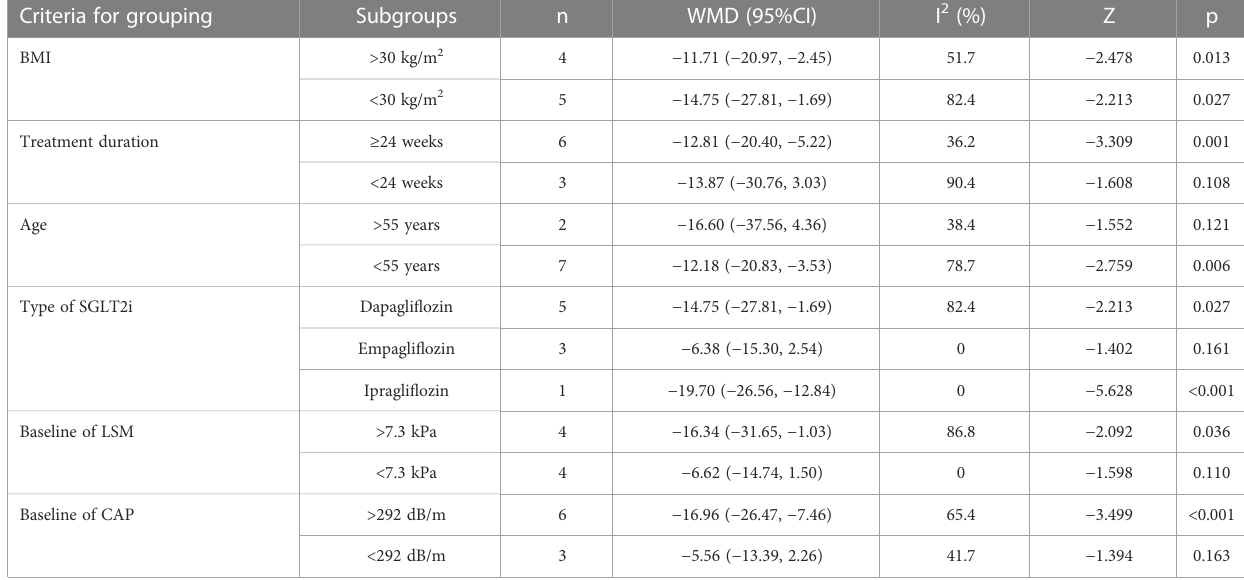
TABLE 3 Subgroup analyses of CAP based on BMI, treatment duration, age, type of SGLT2i, and baseline of LSM and CAP. Criteria for